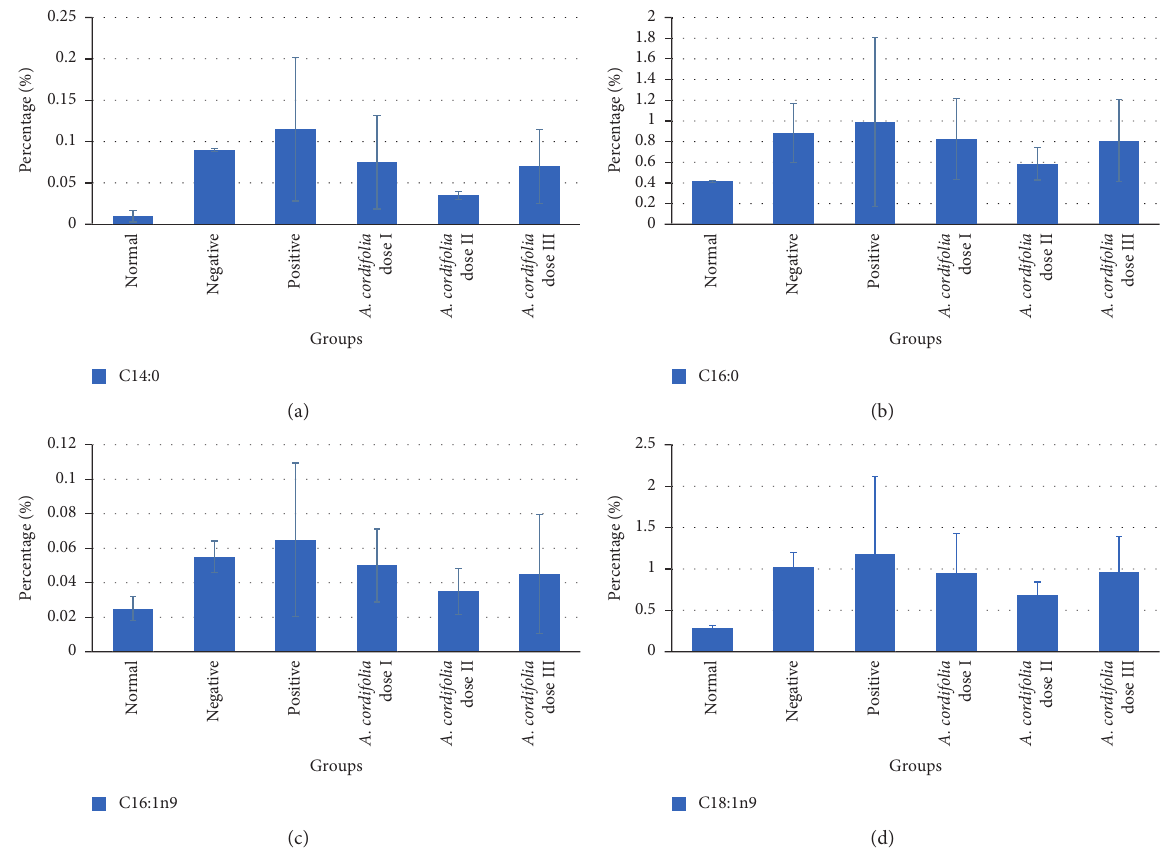
Figure 2: The level of plasma saturated fatty acid medium-chain ( C < 20) higher in diabetic rats as compared to normal rats but lower in unsaturated fatty acids medium-chain. Oral administration of A. cordifolia leaves extract doses 25, 50, and 100mg/kg body weight, and glibenclamide 0.51mg/kg BW lowered the plasma fatty acid as compared to untreated diabetic rats. All values are described as mean ± SD for five rats in each group. (a) C14 :0 � myristic acid methyl ester; (b) C16:0 � palmitic acid methyl ester; (c) C16:1n9 � palmitoleic acid methyl ester; (d) C18:1n9 � oleic acid methyl